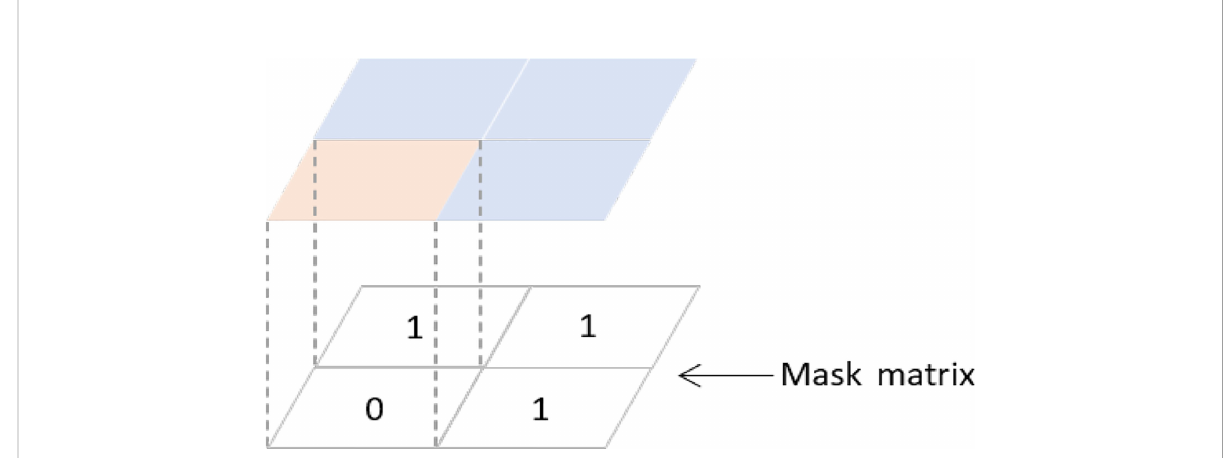
FIGURE 4 Idea of Mask method. The antique-white areas represent land areas and the blue areas represent ocean